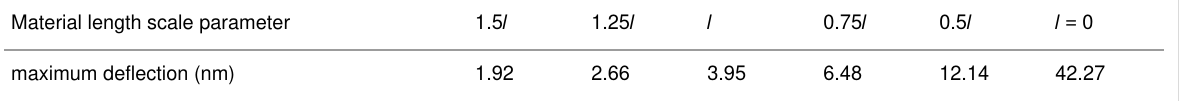
Table 8: The sensitivity of dynamic of manipulation to size effects (length = 25 µm and aspect ratio = 30).